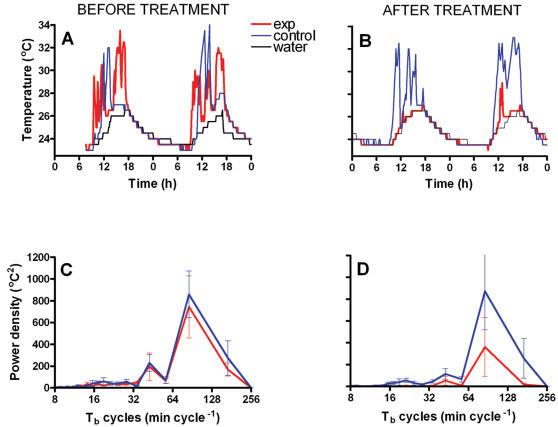
Before treatment, both control (blue lines) and experimental (red lines) animals performed characteristic shuttling behaviour between heating and cooling environments, resulting in periodic oscillations in body temperature (a). After administration of capsazepine, the body temperature of experimental animals ceased to oscillate periodically, while body temperature patterns of control animals remained unchanged (b). Both (a) and (b) show representative examples of data from the same pair of animals. Body temperature time series were transformed into a frequency domain, and the periodogram of the control and experimental animals before treatment shows regular body temperature cycles at 43 and 86 min cycle−1 (c). After treatment, these regular cycles disappear when TRPV1 and TRPM8 were blocked, but there is no change in control animals (d). Means from all animals±s.e. are shown in c and d.